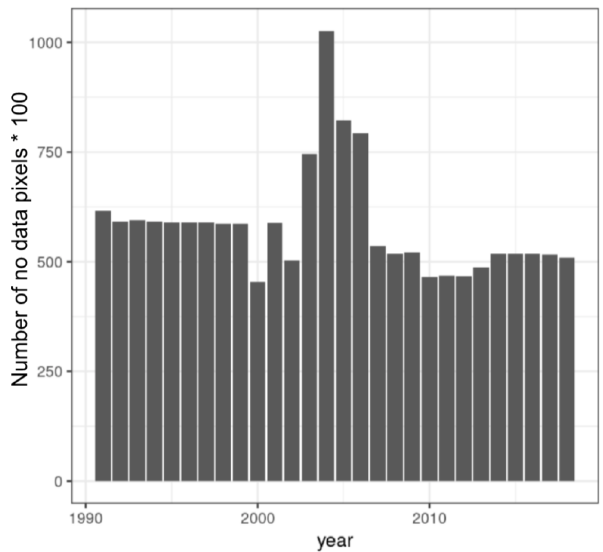
Figure A1. Number of data gaps or not available values (NAs) × 100 in the ESA-CCI v4.5 across years during the analyzed